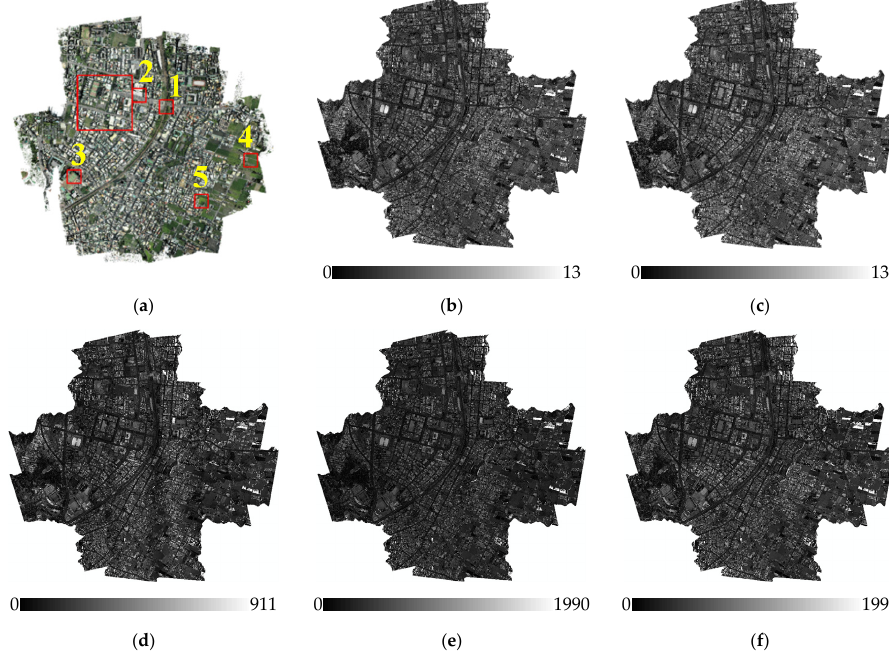
Figure 8. Results of normalized intensity and backscattering coefficient: ( a ) optical image, ( b ) original backscattering coefficient, ( c ) normalized backscattering coefficient, ( d ) original intensity, ( e ) corrected intensity, and ( f ) normalized intensity.